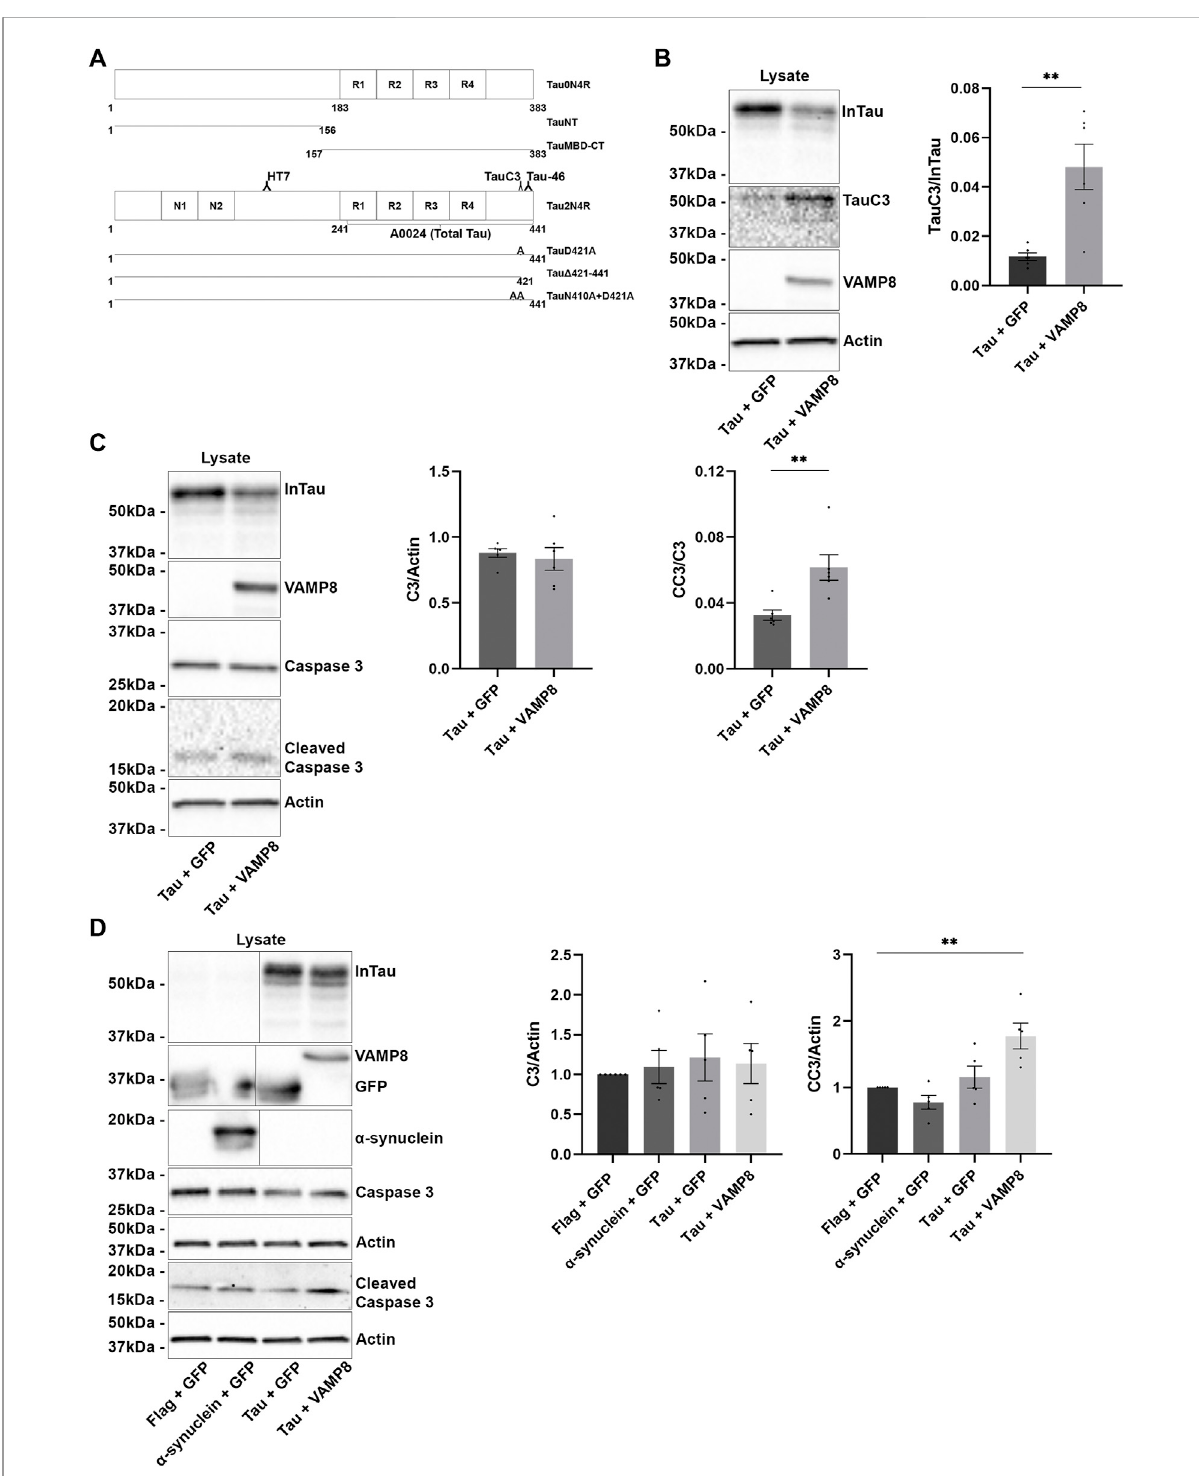
FIGURE 1 OverexpressionofVAMP8increasesthecleavageofTaubyCaspase3andincreasestheamountofactivecaspase-3inthecelllysate.Forallthe fi gures, GFP alone corresponds to GFP-empty vector. (A) Schematic representation of Tau constructs and Tau antibodies. All the experiments were carried out with 0N4R Tau isoform. The constructs TauNT and TauMBD-CT were produced from 0N4R. For the antibodies, the isoform 2N4R was used for consistency with the literature. For B and C, N2a cells were transfected either with Flag-Tau and GFP-empty or Flag-Tau and GFP- VAMP8 plasmids. (B) Representative Western blot with the anti-Tau antibody A0024 recognizing total intracellular Tau (InTau) and the antibody